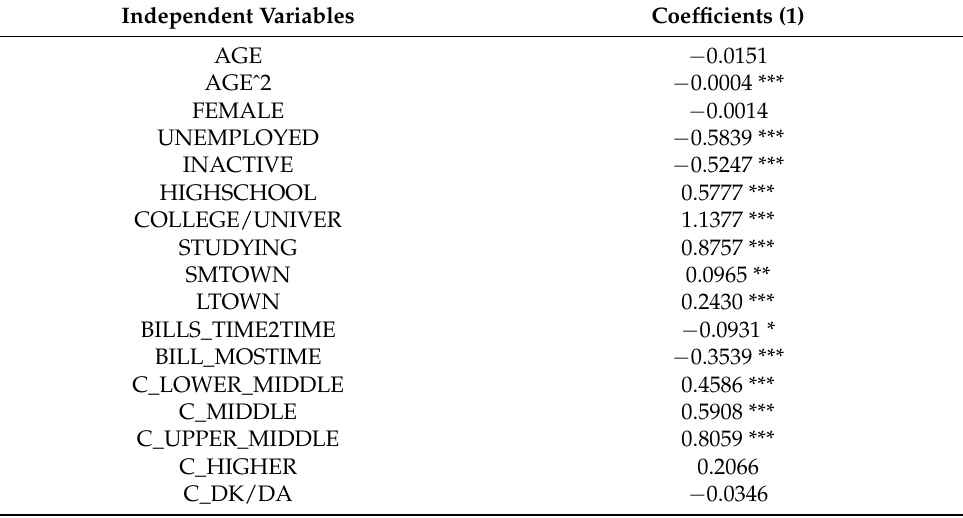
Table 2. Weighted coefficient estimates for selection equation (dependent variable: INTERNET_USE).